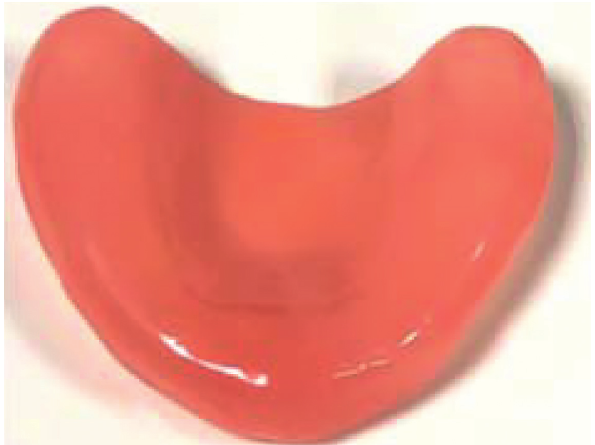
Figure 2: Example of an acrylic resins Triplex Hot ® sample.